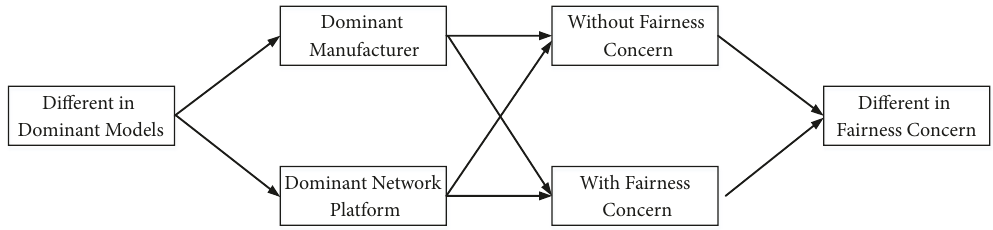
Figure 2: Decision models with different dominant